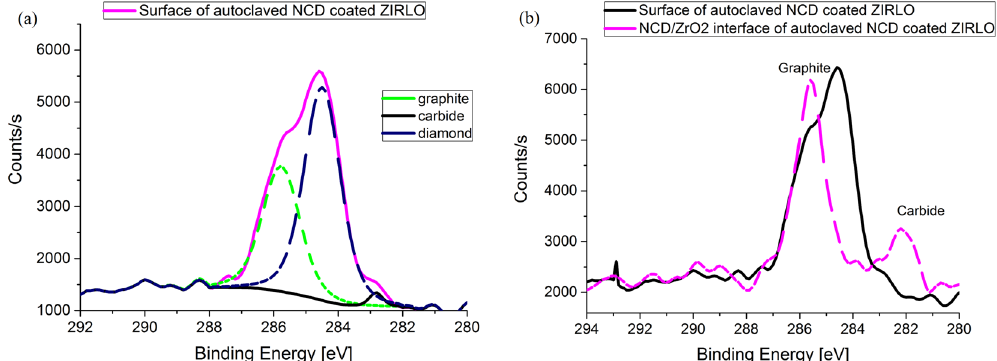
Figure 3. C1s lines of ZIRLO coated with NCD after calibration on the basis of the Zr 3d5/2 line. The areas analyzed were on the NCD surface and at the NCD/ZrO 2 interface after hot steam exposure (400 °C, 4 days). Four different states of carbon are evident ( a ): graphite, with a binding energy of 285.4 eV; diamond, with a binding energy of 284.2 eV; carbon in a single bond with oxygen, with a binding energy of 286.1 eV; and carbide, with a binding energy of 282 eV. Carbides were also present below the NCD layer ( b